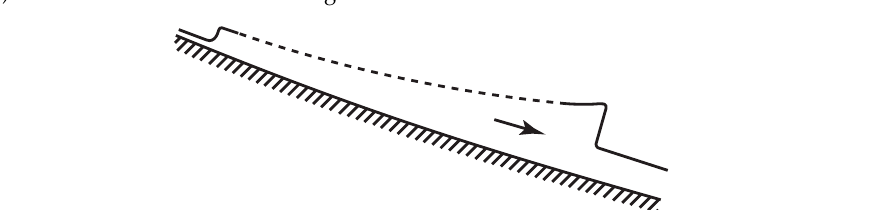
Figure 6. ( a ) Motion on a wide slope, Coulomb dry friction; ( b ) Motion on a wide slope, Grigorian dry friction; ( c ) Motion in a chute with a rectangular cross-section.